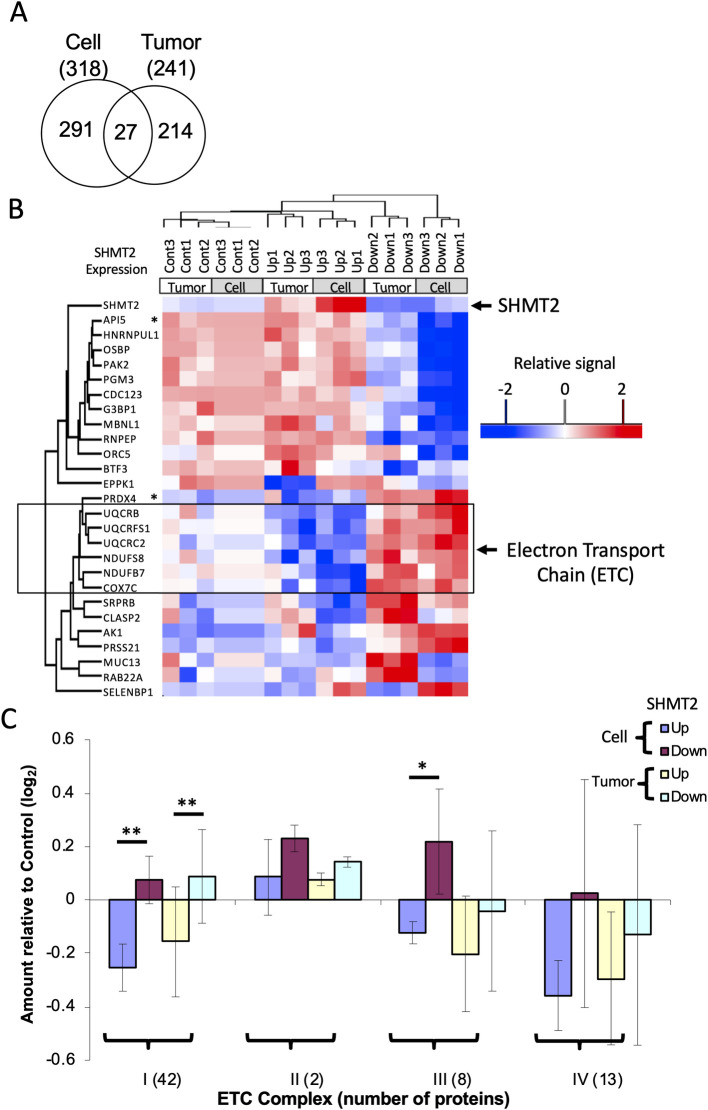
SHMT2 expression levels influence the expression of electron transport chain proteins.Proteins from HeLa-Ss cells and HeLa-Ss tumors with different SHMT2 expression levels (Control, Up, and Down) were analyzed by MS by using a TMT protocol. (A) Venn analysis of proteins differentially expressed as a function of SHMT2 in HeLa-Ss cells versus tumors. Proteins with significantly differential expression among control (Cont), SHMT2-Up, and SHMT2-Down was determined by ANOVA analysis. (B) Unsupervised hierarchical cluster analysis of 27 proteins significantly differentially expressed as a function of SHMT2 level in both cells and tumors (as depicted in A, above). ETC: electron transport chain. * PRDX4: Peroxiredoxin-4; API5: Apoptosis inhibitor 5. (C) Relative quantification of electron transport chain proteins of complex I, II, III and IV. * p < 0.01; ** p <0.001 (Student’s t-test).